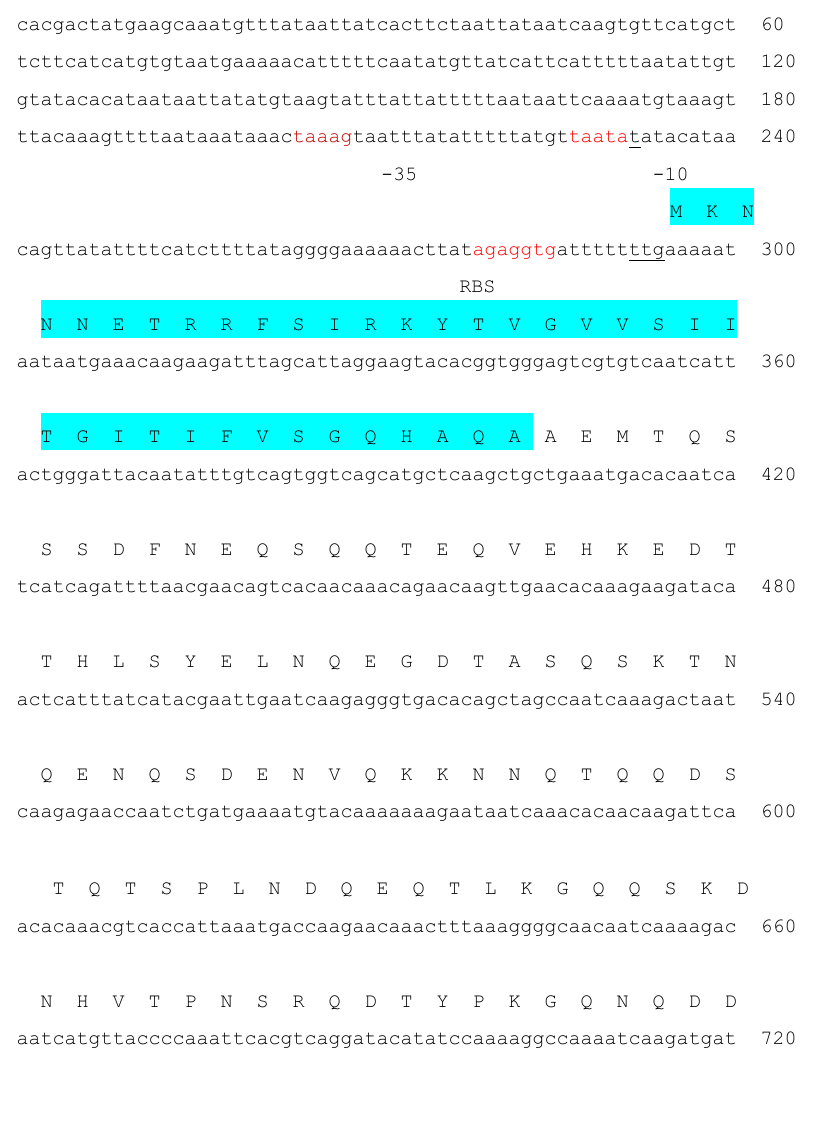
Figure 1. Nucleotide and deduced amino acid sequences of the organic solvent tolerant lipase gene of S. epidermidis